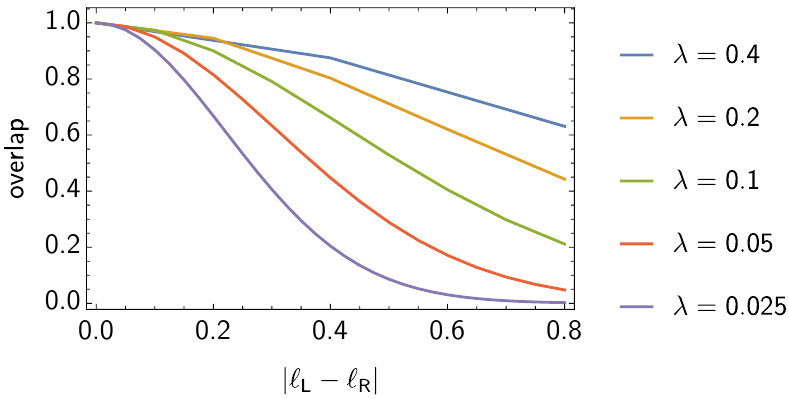
Figure 9 . Same overlap as in figure 8 but plotted on a smaller linear scale for clarity. The numerics suggest that if we hold ‘ L − ‘ R fixed as λ → 0 , the overlap goes to zero. So in the JT regime, we expect that the states | ‘ L , ‘ R i , | ‘ 0 , ‘ 0 i are orthogonal. However, note that states that differ by only L R one unit of n (e.g. a small change δ‘ ∼ λ ) have a large